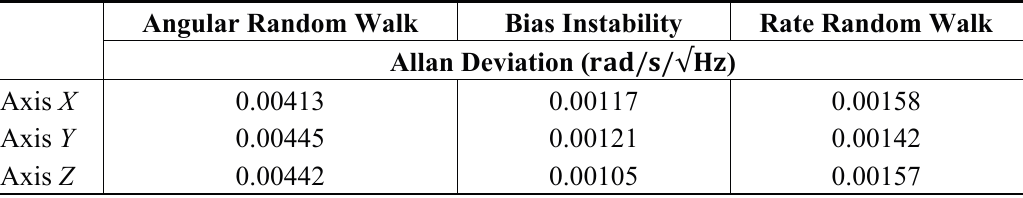
Table 2. Gyroscope noise